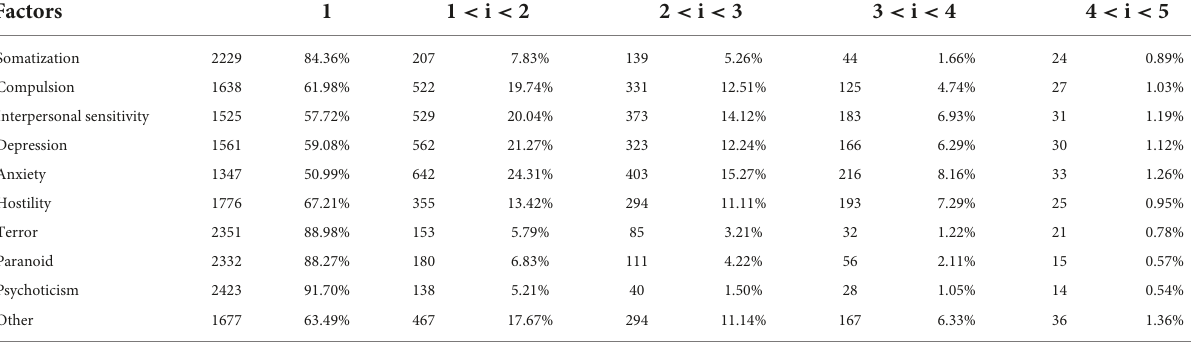
TABLE 3 Distribution of SCL-90 scores in all dimensions (n, %).